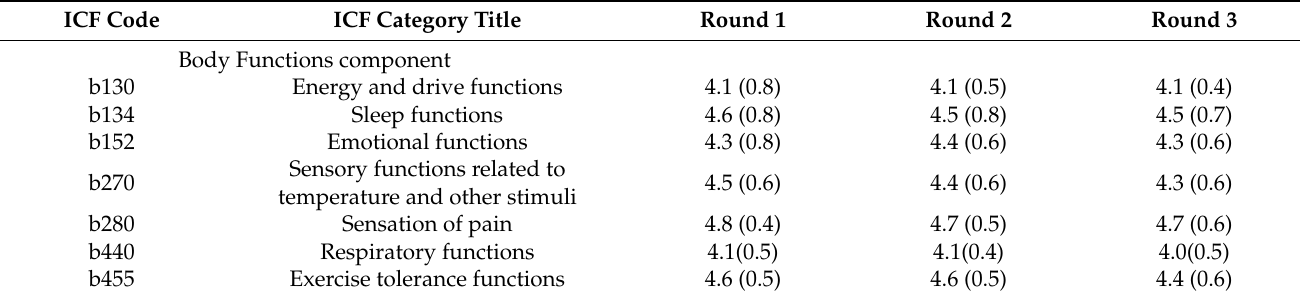
Table 1. International Classification of Functioning, Disability, and Health categories of the body functions and body structures components rated as important for the assessment of chronic burn injury over the three rounds of Delphi exercises.